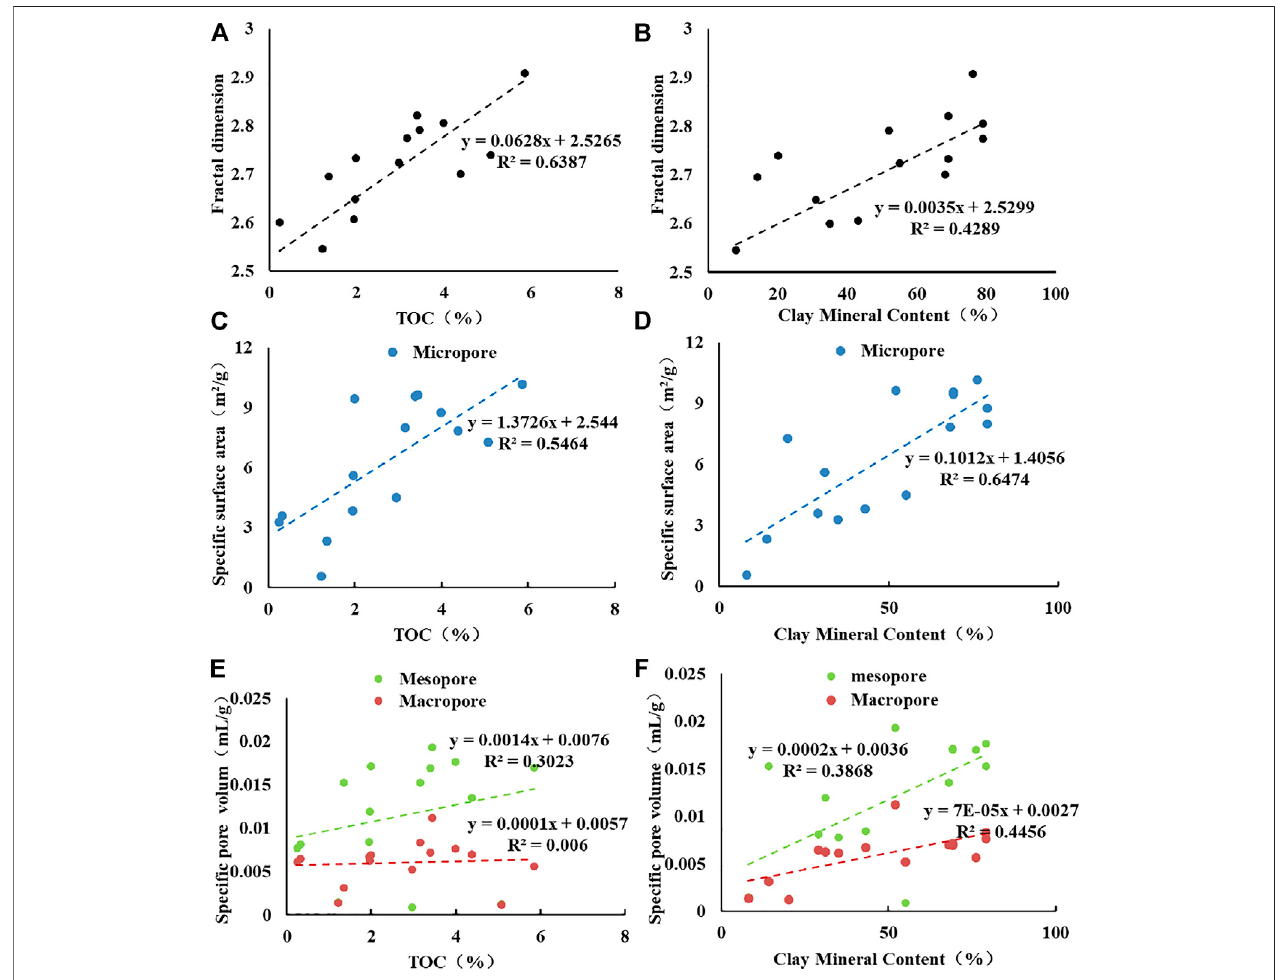
FIGURE 10 | Relationship between organic carbon content, clay mineral content, and pore structure characteristic parameters. (A) The relationship between organic carbon and fractal dimension. (B) The relationship between clay minerals and the fractal dimension. (C) The relationship between organic carbon and speci fi c surface area. (D) The relationship between clay minerals and speci fi c surface area. (E) The relationship between organic carbon and speci fi c pore volume. (F) The relationship between clay minerals and speci fi c pore volume.